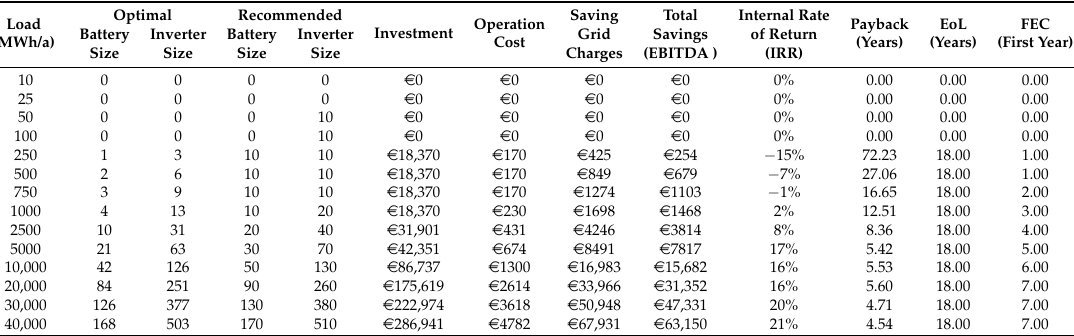
Figure 12. Industrial load profile B, C, and D with monthly billing scheme ( left ), and battery state of charge and state of health ( right ). Table 6. Profile A with yearly billing scheme and duration factor of 4431 h/a. Peak load capping of 5% which represents 20 capped peaks per